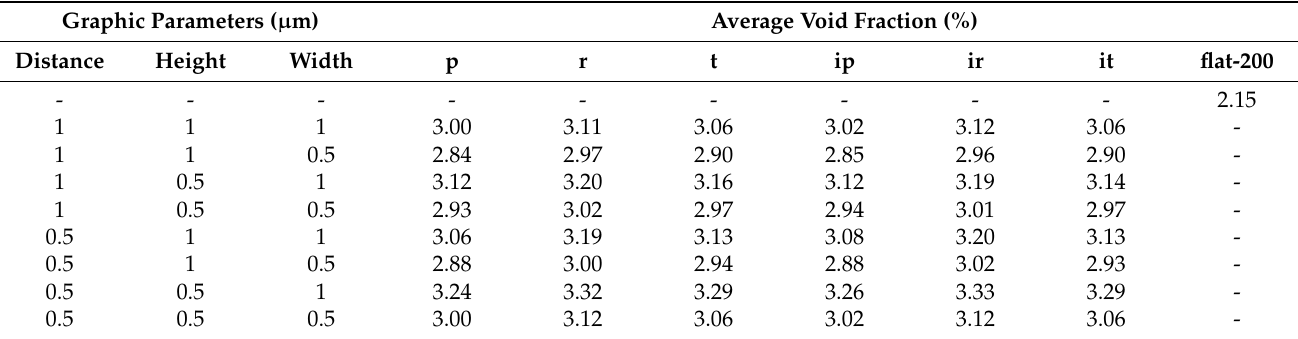
Table 4. The average void fraction of micro-nano surface electrodes under different structures and graphic parameters and the vertical flat electrode at the same voltage (U = 2